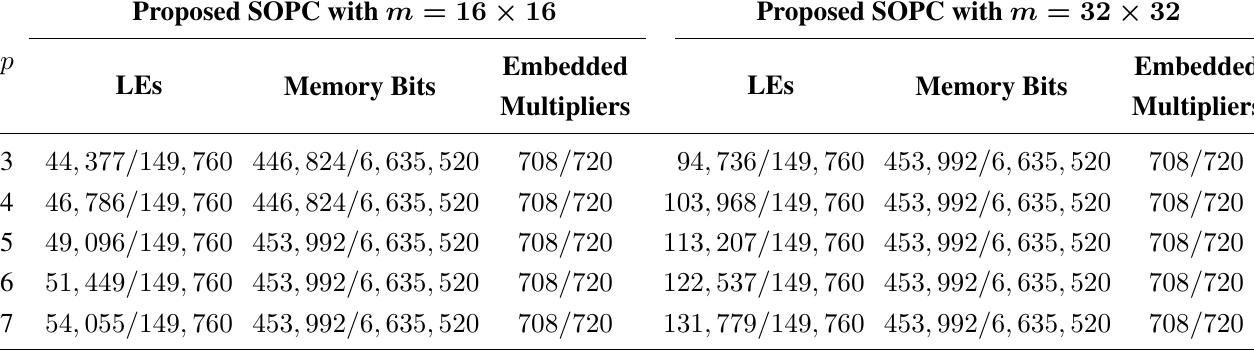
Table 3. Hardware resource consumption of the SOPC system using proposed GHA architecture as hardware accelerator for vector dimensions m = 16 × 16 and m = 32 × 32 . Proposed SOPC with m = 16 ×